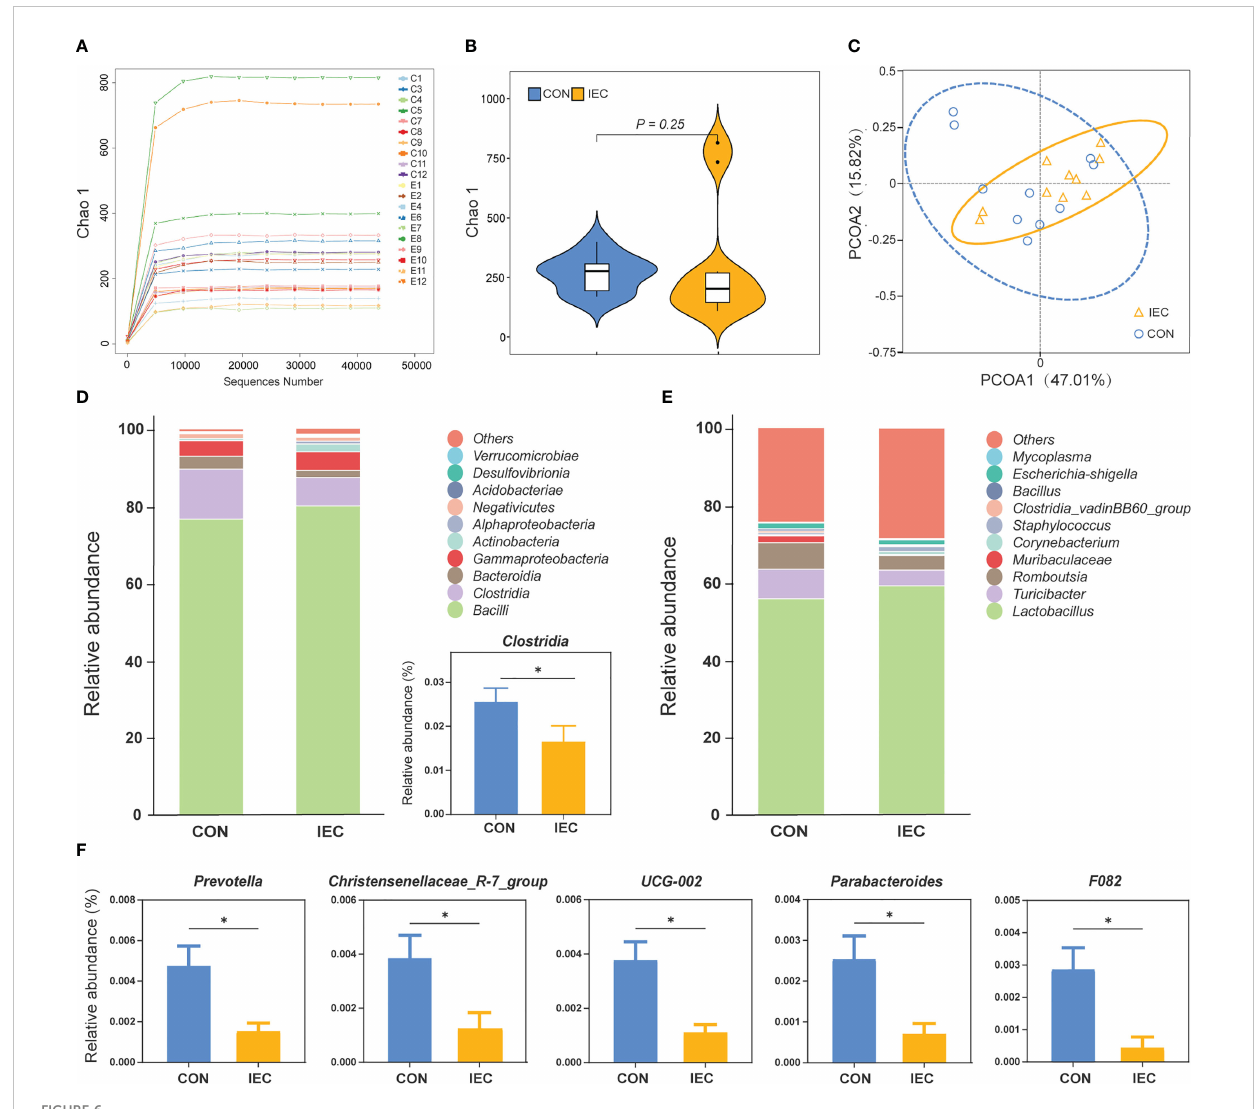
FIGURE 6 16S rRNA sequence analysis of ileal contents in rats and the micro fl ora data diversity analysis (n =10/group) at 48 hpi. (A) Rarefaction curve of ileum fl ora. (B) Chao-1 Diversity Index analysis of ileum fl ora between the two groups. (C) PCoA diagram of Beta diversity in ileum fl ora between the two groups. (D) and (E) Relative abundance of species at class and genus level of ileal fl ora between the two groups. (F) Differential species analysis of ileum fl ora at the genus level between the two groups. The data are presented as mean ± SEM. Asterisks indicate signi fi cant difference between the IEC group and the CON group (* P < 0.05). hpi, hours post